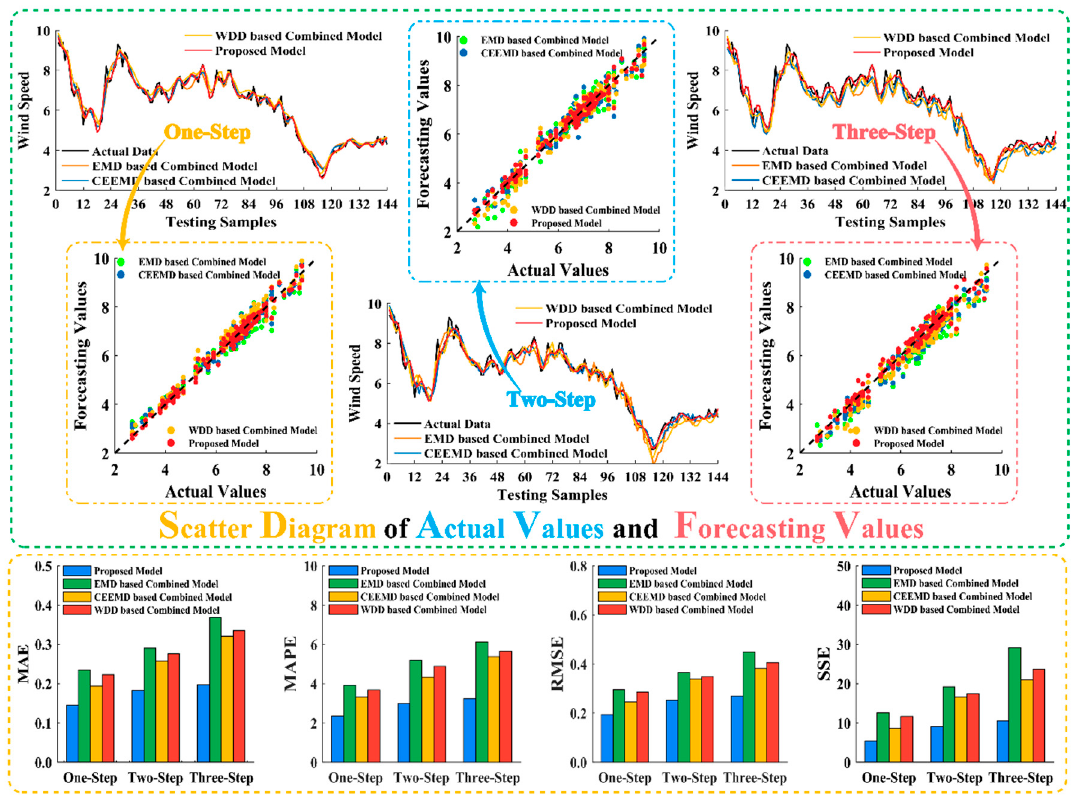
Figure 4. Comparison results of experiment 2 at site 2. Table 5. Comparison of the evaluation metrics for the proposed strategy with models using different data pretreatment technologies.